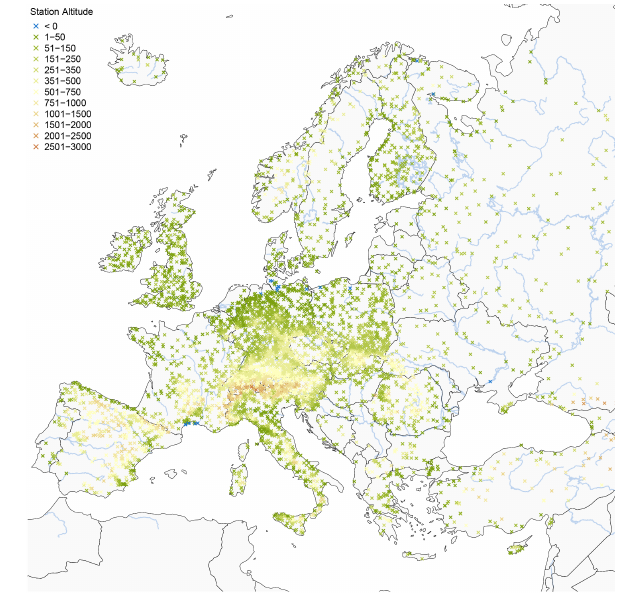
Figure 5. Record length in years of annual maximum flow series.